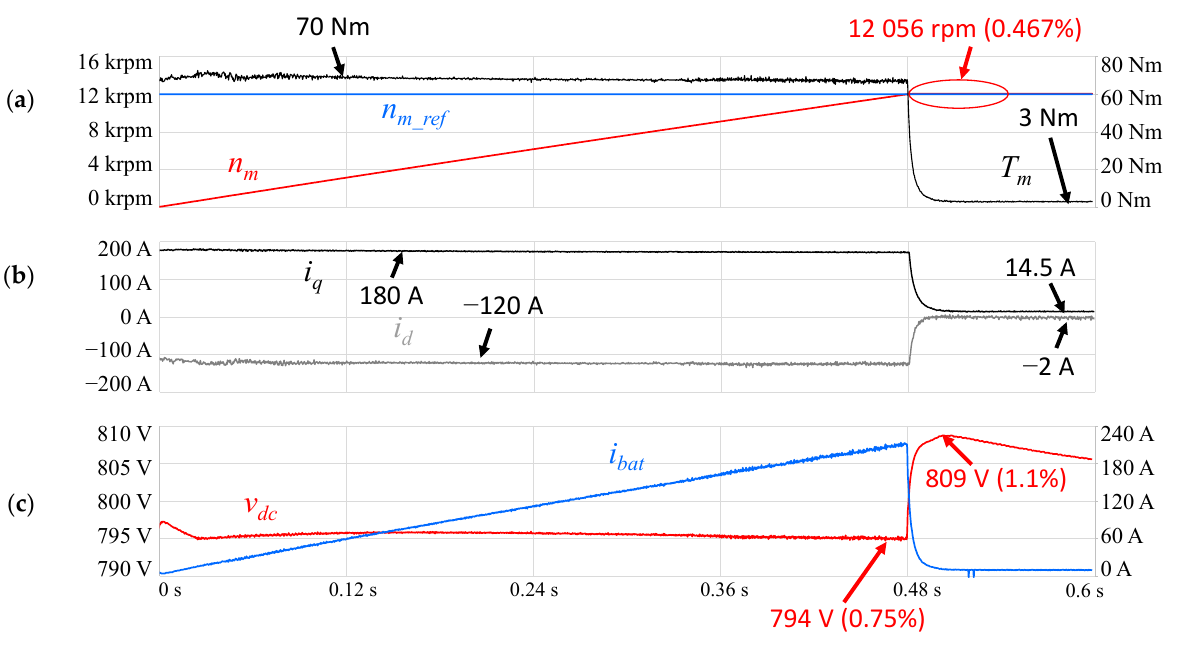
Figure 7. Simulation results of the traction system accelerating from a stop to nominal speed without a load, representing ( a ) the torque ( T m ), speed ( n m ) and reference speed ( n m_ref ) of the SRPM machine; ( b ) the stator windings’ currents ( i d , i q ); ( c ) the dc link voltage ( v dc ) and the battery current ( i bat